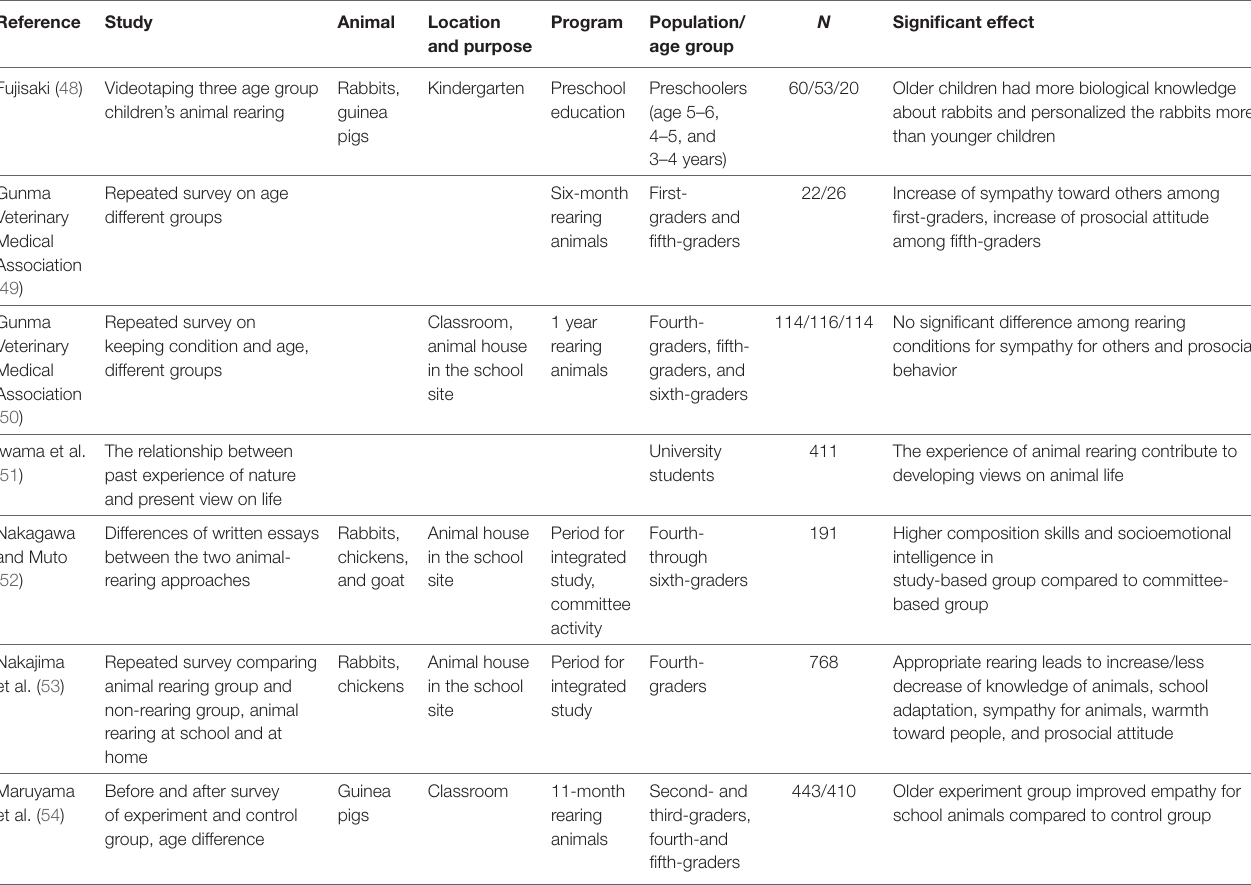
TAbLe 2 | Original studies included in the review of Japanese animal-rearing